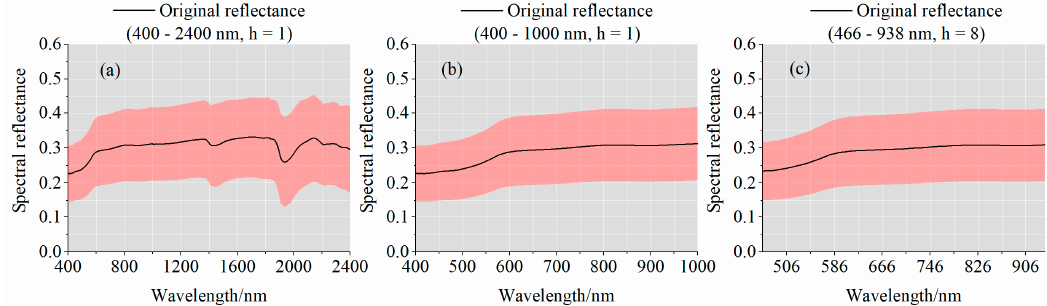
Figure 5. Soil average spectral curve. ( a ) the average spectral curves of 171 soil samples in the 400–2400 nm band with 1 nm intervals; ( b ) the average spectral curves in the 400–1000 nm band with 1 nm intervals; ( c ) the average spectral curves in the 466–938 nm band with 8 nm intervals.